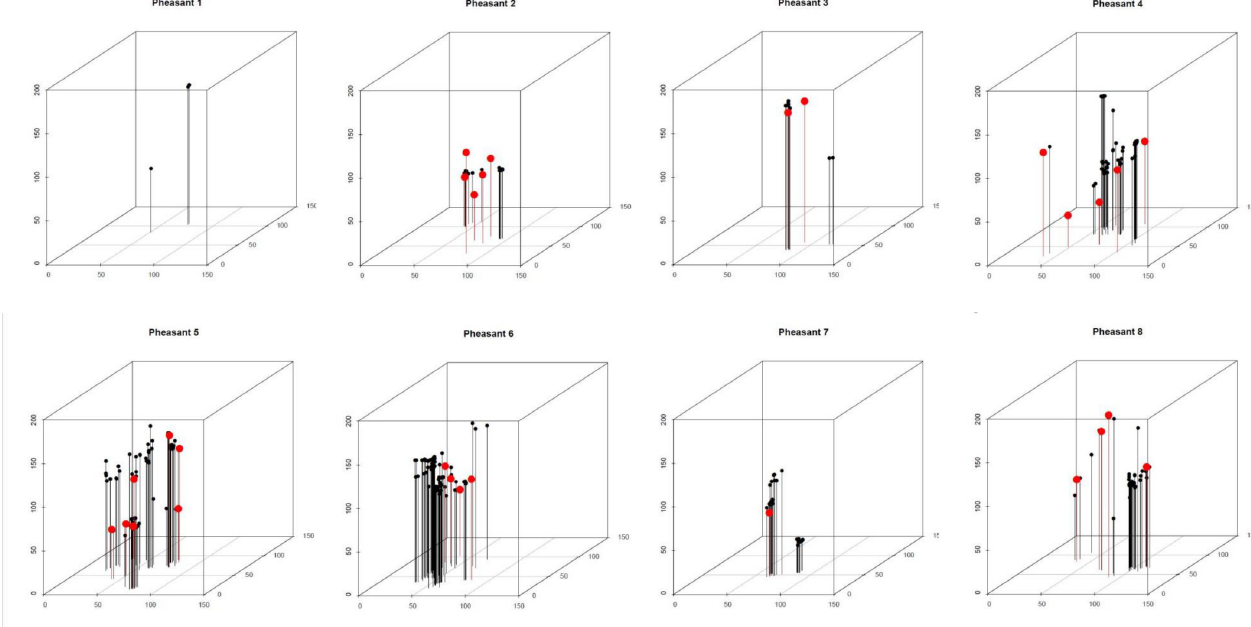
Fig 4. Three-dimensional plots locations of pieces of metal in pheasant carcasses. This shows the locations of metal shards (black circles) and whole or near- whole shotgun pellets (red circles) in the carcasses of eight pheasants. The sizes of the plotted symbols are not to scale. The axes are in millimetres. The grid on the base of each diagram shows 50x50 mm squares.